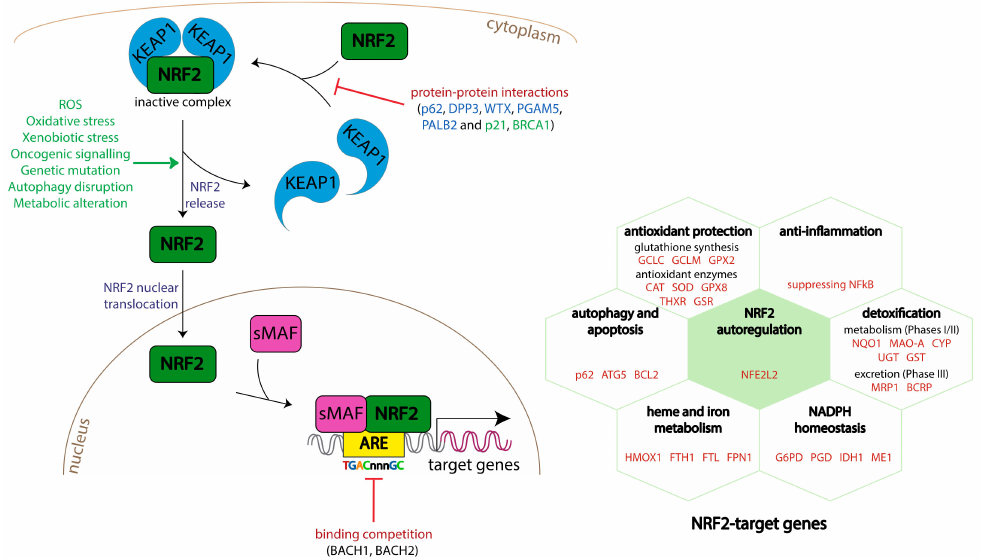
Figure 3. Activation and regulation of the NRF2 signalling pathway . Under stress conditions, NRF2 is released from KEAP1 and translocates to the nucleus, where it interacts with cofactors and binds specific response elements (ARE) to regulate the transcription of its many target genes. ARE, Antioxidant Response Element; ATG5, Autophagy-related 5; BACH1/2, BTB and CNC homology 1/2; BCL2, B-cell lymphoma 2; BCRP, Breast cancer resistance protein; BRCA1, Breast cancer type 1; CAT, Catalase; CYP, Cytochrome p450; DPP3, Dipeptidyl peptidase 3; FTH1, Ferritin Heavy Chain 1; FTL, Ferritin light chain; FPN1, Ferroportin1; G6PD, Glucose-6-phosphate dehydrogenase; GCLC, Glutamate-cysteine ligase catalytic subunit; GCLM, Glutamate-cysteine ligase regulatory subunit; GPX2/8, Glutathione peroxidase 2/8; GSR, glutathione reductase; GST, glutathione S-transferase; HMOX1, Heme Oxygenase 1; IDH1, isocitrate dehydrogenase 1; MAO-A, monoamine oxidase A; ME1, malic enzyme 1; MRP1, Multidrug resistance protein 1; NQO1, NAD(P)H:quinone oxidoreductase 1; NF- κ B, Nuclear factor kappa-light-chain-enhancer of activated B cells; p21, cyclin-dependent kinase inhibitor 1; p62, sequestosome 1; PALB2, Partner and localizer of BRCA2; PGAM5, Phosphoglycerate mutase 5; PGD, 6-phosphogluconate dehydrogenase; ROS, Reactive oxygen species; sMAF, small musculoaponeurotic fibrosarcoma; SOD, Superoxide dismutase; THXR, Thioredoxin reductase; UGT, UDP-glucuronosyltransferase; WTX, Wilms tumour gene on the X